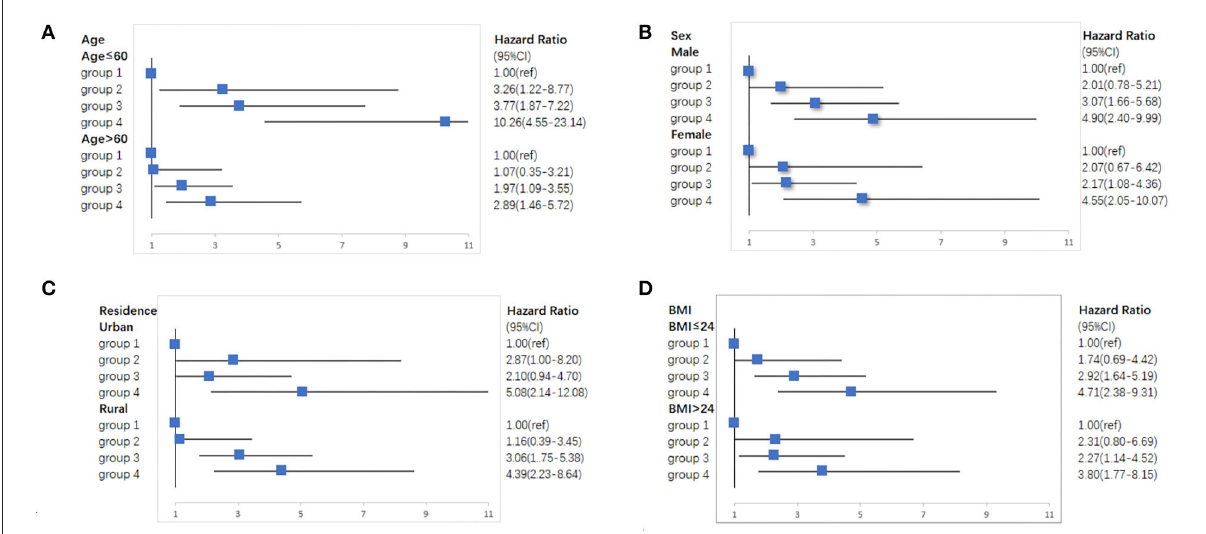
FIGURE3 Subgroup analyses of the association of elevated-CRP levels and hypertension with new-onset stroke in CHARLS. (A) Subgroup analyses according to age. (B) Subgroup analyses according to sex. (C) Subgroup analyses according to residence. (D) Subgroup analyses according to